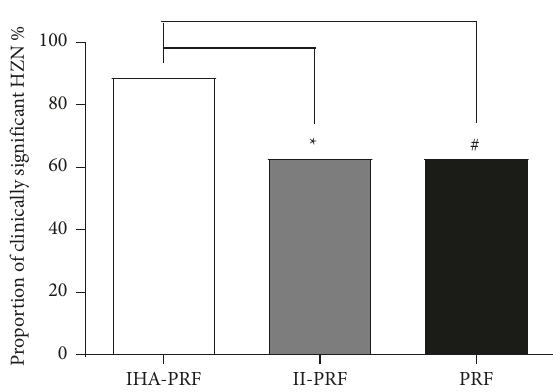
Figure 4: The group IHA-PRF effective rate was considerably higher than the other two groups. Patients in the three groups were followed up for 12 weeks following treatment. The effective rate in group IHA-PRF (88.9%) was considerably higher than group II- PRF (63.0%) and group PRF (63.0%). Compared with group II- PRF, ∗ P < 0 . 05. # P < 0 . 05, compared with group